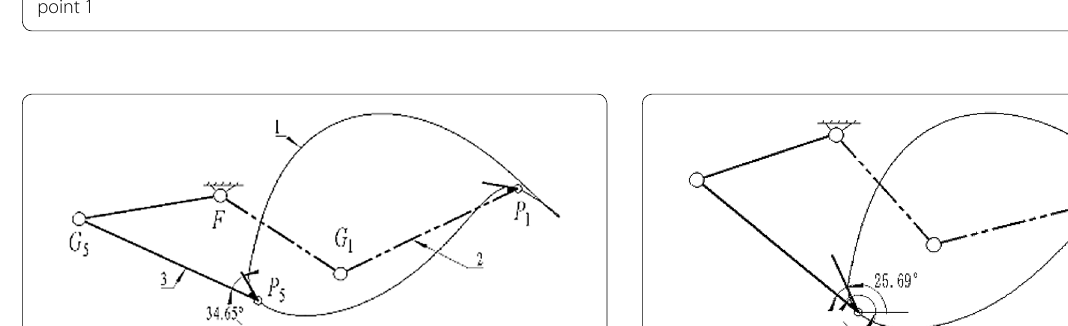
3 Angular Displacement Relationship Model and Single‑DOF (SDOF) Model In the previous section, the relative positional relation- ships between the key points of the trajectory and the rotating hinge points F of the two bars were prelimi- narily established through the five key points modeling method, and the lengths of both bars were calculated. (9)